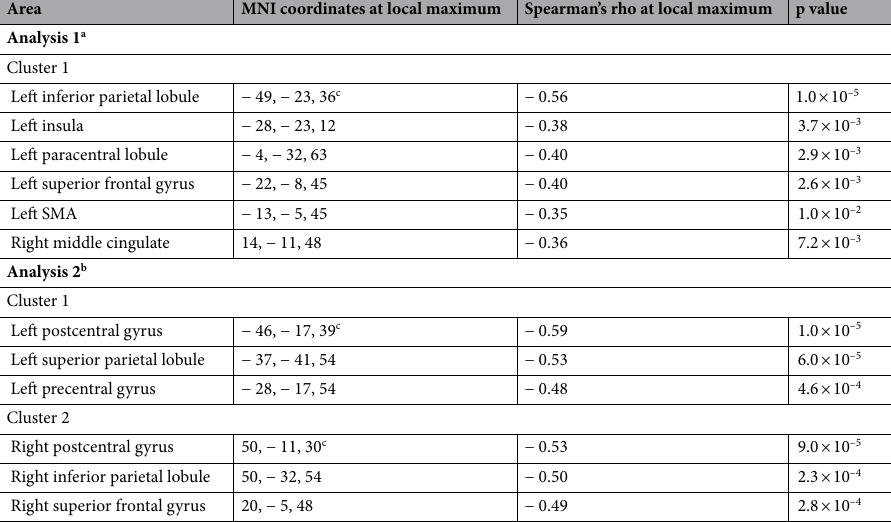
Table 2. Local maxima in clusters found through Spearman correlation of anxiety scores and amygdala functional connectivity. Cluster 1: 2857 voxels (rho = − 0.50; p = 1.2 × 10 –4 ); Cluster 2: 2275 voxels (rho =